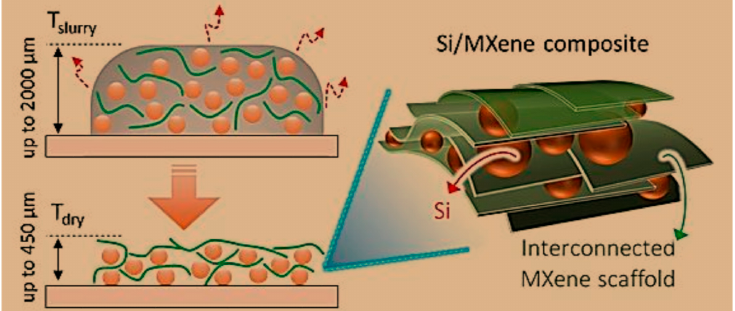
Figure 11. During the slurry-casting process, sheets of MXene material combine with silicon particles to form a network that allows for a more orderly reception of lithium ions, which prevents the silicon anode from expanding and breaking.